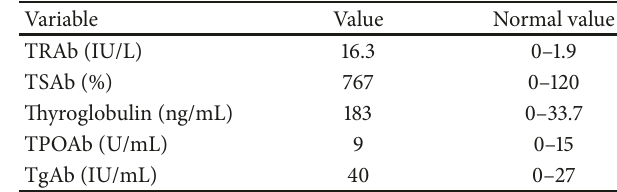
Table 1: General laboratory data. Table 2: Thyroid laboratory